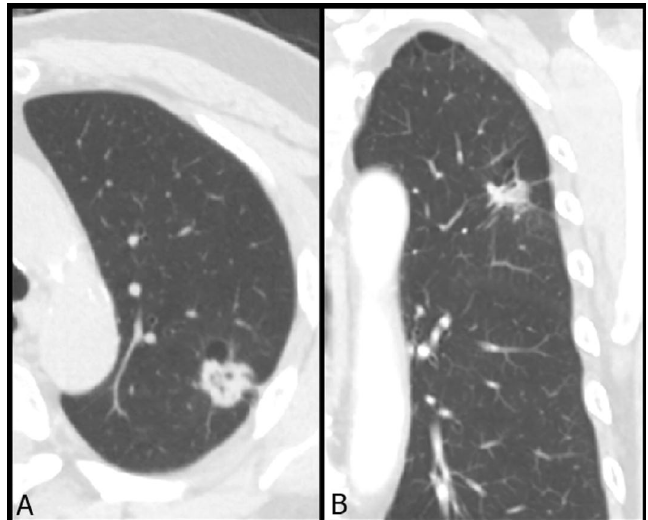
Figure 2. A typical example case of subsolid nodule with abnormal cystic-like airspace in LUL. A 65-year-old man had a 2.1 cm part-solid nodule with spiculated border in LUL. The ( A ) axial and ( B ) coronal CT images showed an abnormally dilated cystic-like airspace inside the lesion. The patient underwent video-thoracoscopic lobectomy of LUL. Further pathologic report demonstrated invasive pulmonary adenocarcinoma in LUL, Stage T1cN0M0. LUL left upper lobe.